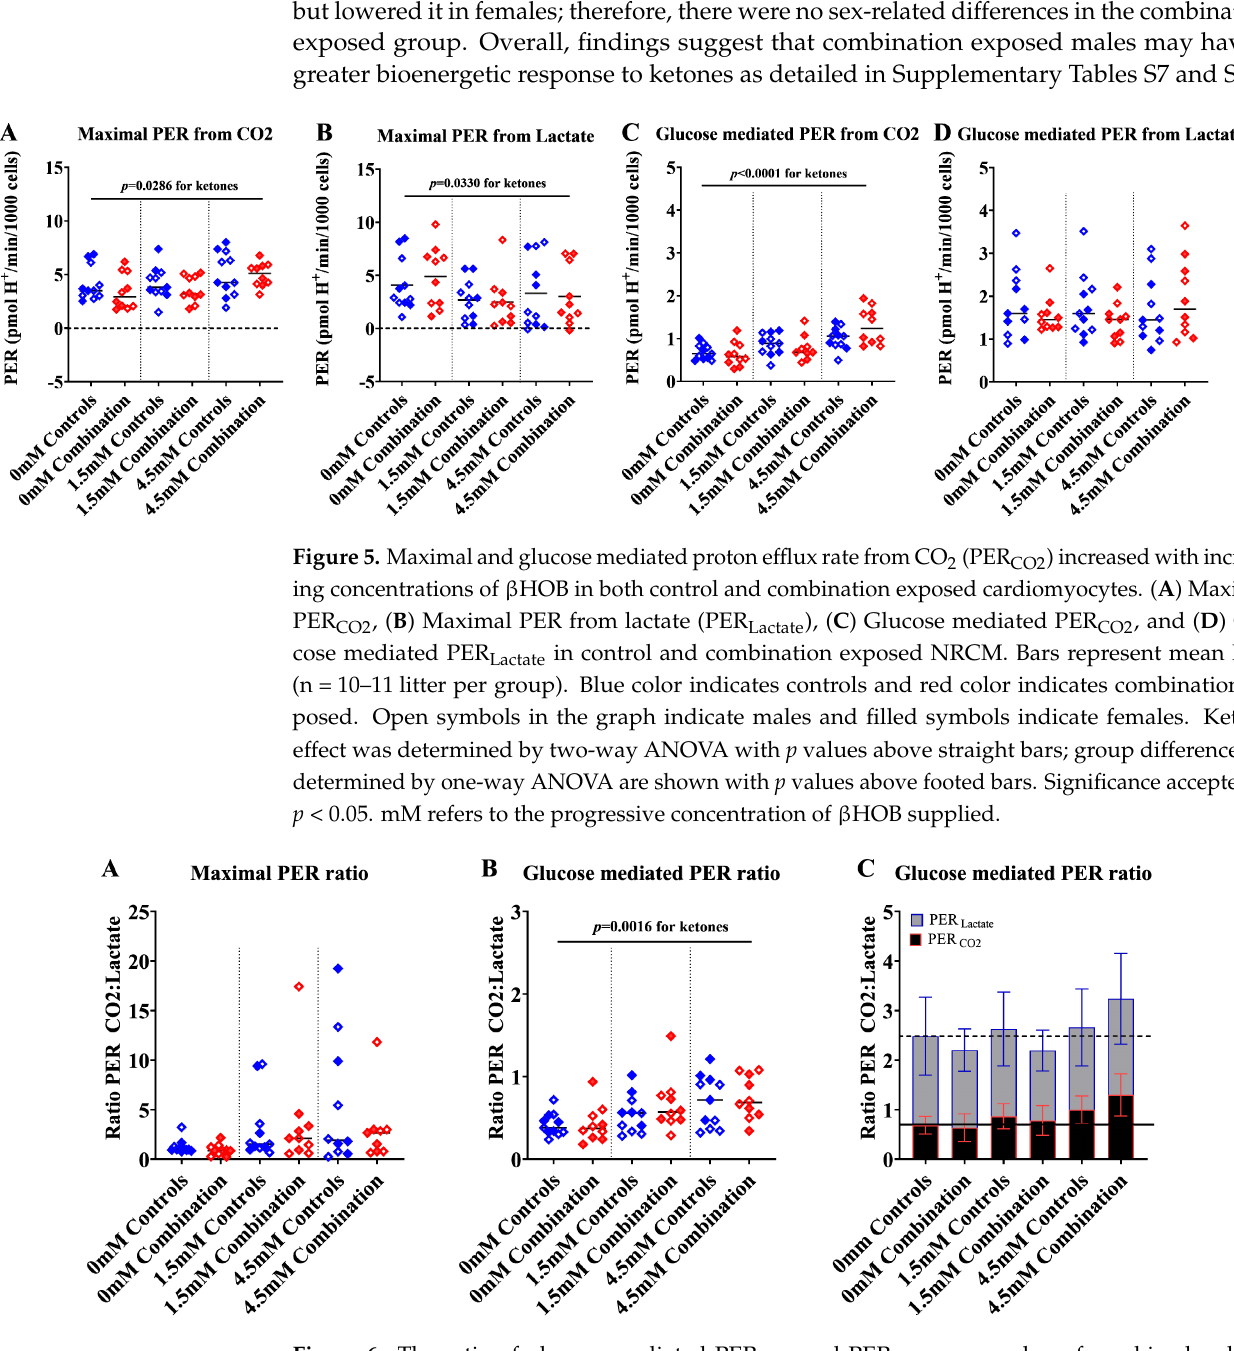
Figure 6. The ratio of glucose mediated PER CO2 and PER Lactate , a marker of aerobic glycolysis, increased with increasing concentration of β HOB in both control and combination exposed cardiomyocytes. ( A ) Maximal and ( B ) glucose-mediated PER CO2 :PER Lactate ratio for control and combination exposed NRCM. Bars represent mean ratio (n = 10–11 litter per group). Blue color indicate controls and red color indicate combination exposed. Open symbols in the graph indicate males and filled symbols indicate females. Ketone effect was determined by two-way ANOVA and the significance accepted at p < 0.05. ( C ) Bar graphs illustrate the combined contributions of PER CO2 (black with red border) and PER Lactate (grey with blue border) to the PER Total in control and combination exposed NRCM. Bars represent the mean ± SD. For illustration purposes, the solid line highlights the mean PER CO2 and the dashed line highlights the mean PER Lactate for control NRCM that were not administered β HOB. mM refers to the progressive concentration of β HOB supplied.